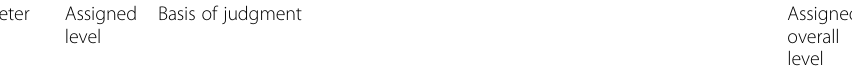
Table 3 Risk of bias assessment